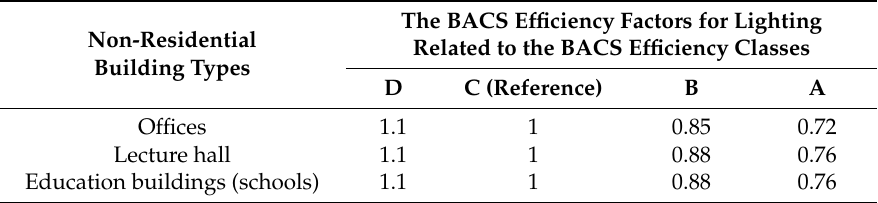
Table 2. The selected BACS efficiency factors for lighting in non-residential buildings